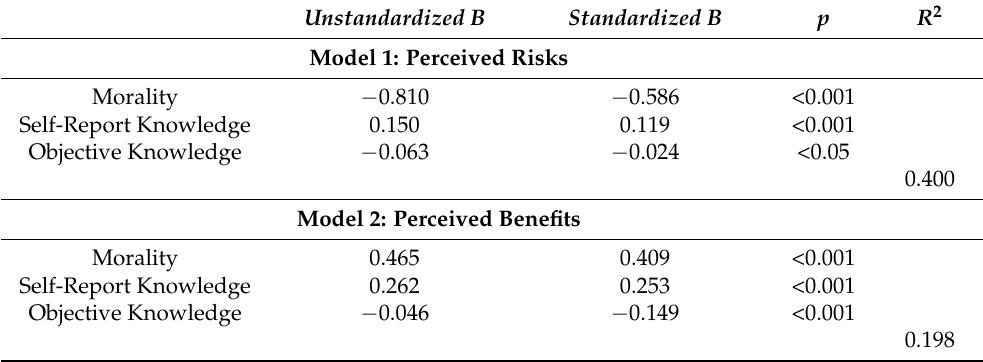
Table 3. Post hoc Regression